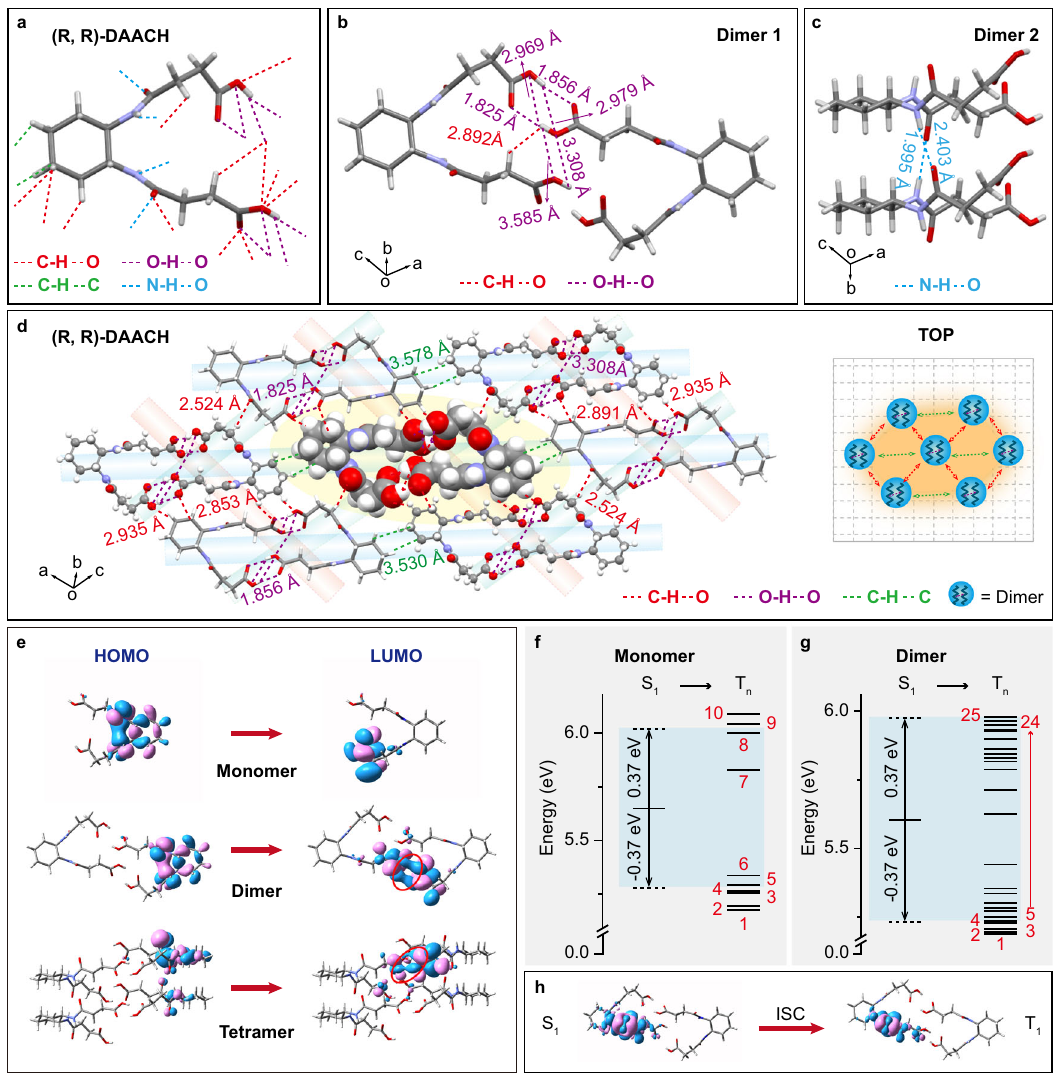
Fig. 3 Single crystal and theoretical analyses of color-tunable CPOA materials. a – d Intermolecular interactions of monomer ( a ), dimer ( b , c ), and molecular packing ( d ) in (R, R)-DAACH single crystal. The central dimer (highlighted by space fi ll mode) is stabilized by six identical dimers via ef fi cient intermolecular interactions through neighbor dimers, thus leading to the diversi fi ed emission species with different cluster sizes. e Frontier molecular orbital distributions for the selected monomer, dimer, and tetramer in (R, R)-DAACH single crystal. f , g TD-DFT calculated energy level diagram of selected monomer ( f ) and dimer ( g ) in (R, R)-DAACH single crystal. h Electron density difference in the singlet and triplet excited state of the